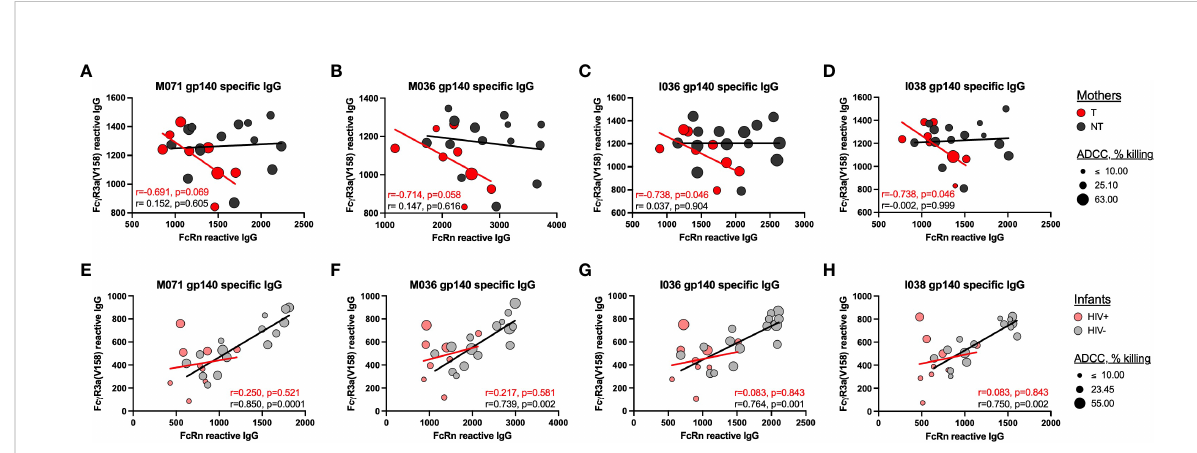
FIGURE 4 Relationship between homologous-Env speci fi c FcRn and FcyR3a(V158) reactive IgG and plasma ADCC. The correlations between gp140- speci fi c FcRn-reactive plasma IgG and gp140-speci fi c FcyR3a(V158)-reactive plasma IgG were evaluated for (A – D) mothers and (E – H) infants using homologous gp140 cohort proteins, including (A , E ) M071 gp140, B and (F) M036 gp140, C, (G) I036 gp140 and D, (H) I038 gp140. The trend lines and inset spearman correlation coef fi cients are shown to demonstrate the relationship between homologous gp140-speci fi c FcRn- reactive plasma IgG and FcyR3a(V158)-reactive plasma IgG for the transmitting mothers (T, red), non-transmitting mothers (NT, dark gray), HIV+ infants (pink) and uninfected infants (HIV-, light gray). The size of the symbol re fl ects the magnitude of ADCC activity against the homologous Env IMC